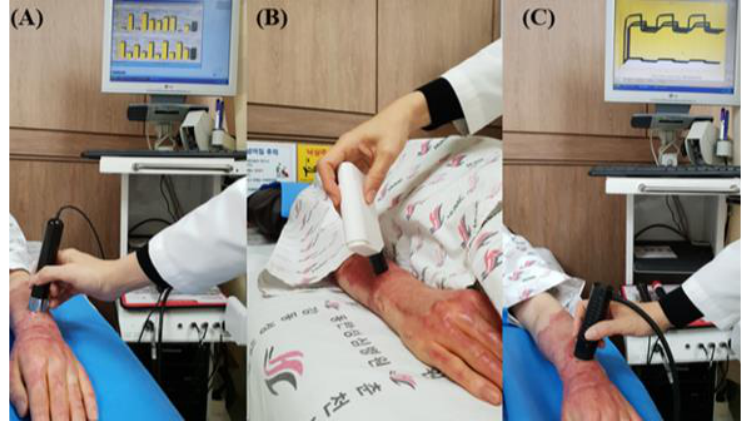
Figure 3. ( A ) Measurement of melanin levels and erythema severity using Mexameter ® (MX18, Courage-Khazaka Electronics GmbH, Germany), ( B ) measurement of sebum using Sebumeter ® (Courage-Khazaka Electronic GmbH, Germany), and ( C ) measurement of elasticity using Cutometer SEM 580 ® (Courage-Khazaka Electronic GmbH, Cologne, Germany).